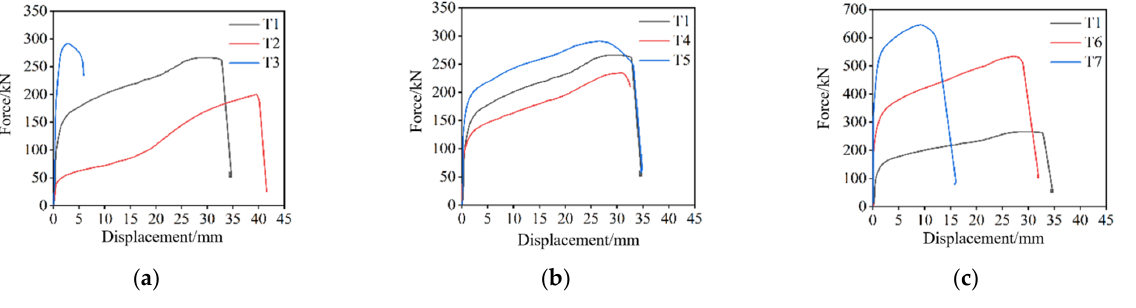
Figure 6. Load–displacement curve: ( a ) thickness group; ( b ) bolt spacing group; ( c ) stiffener rib group. Table 3. Mechanical properties of a T-stub.